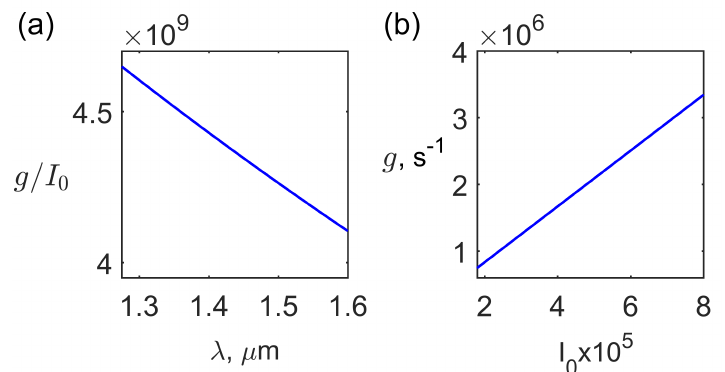
Figure 6. The normalized gain g / I 0 ( s − 2 V − 2 m 2 ) dependence on the optical wavelength λ ( a ); the gain g dependence on the normalized intensity I 0 (V 2 m − 2 s) for the optical wavelength λ = 1.55 µ m ( b